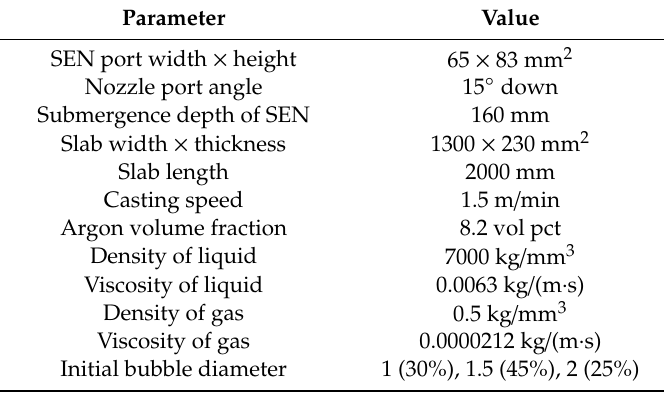
Table 2. Geometry parameters and operation